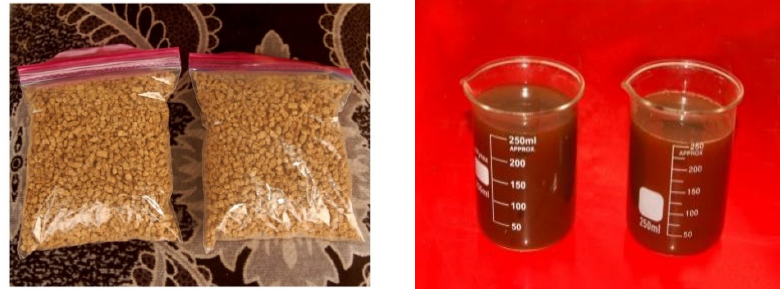
Figure 5. Pelletized solid and liquid digestates from rice husk.